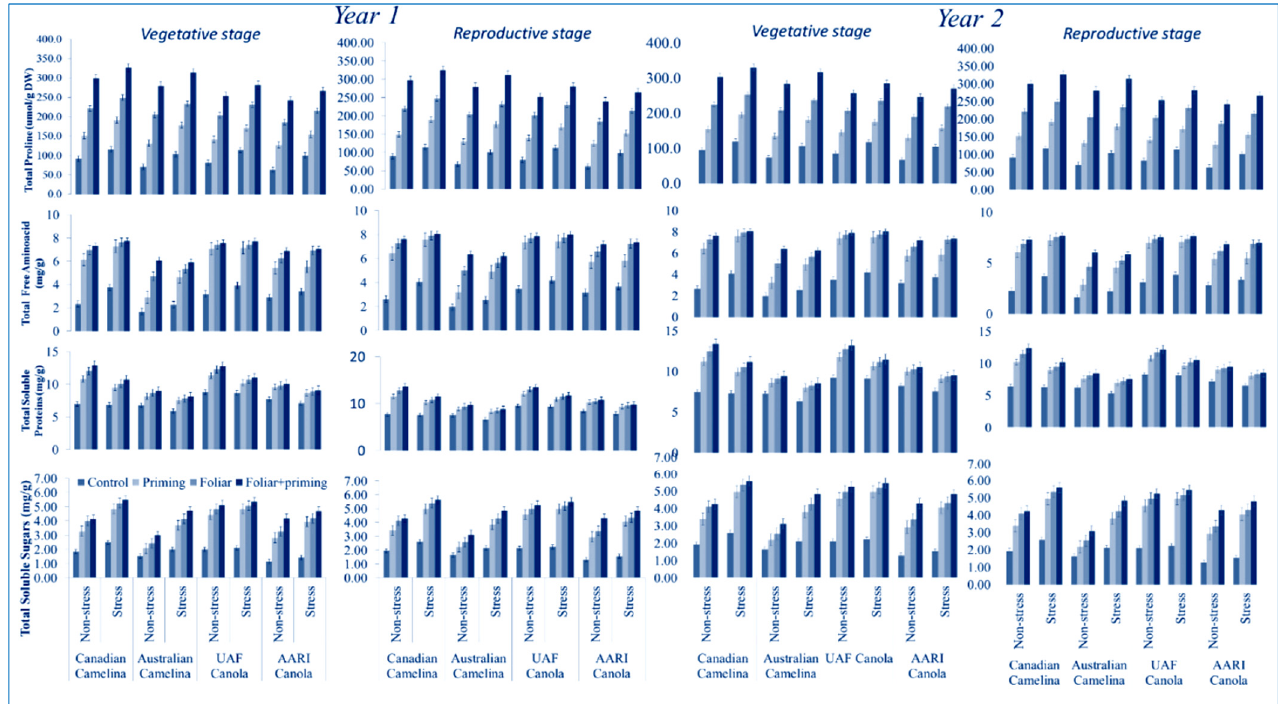
Figure 1. Impact of Se application (seed priming and foliar) on physiological attributes at both stages (vegetative and reproductive) of oilseed crops (camelina and canola) subjected to water deficit in the year 2016 and 2017 (mean values ± S.E).